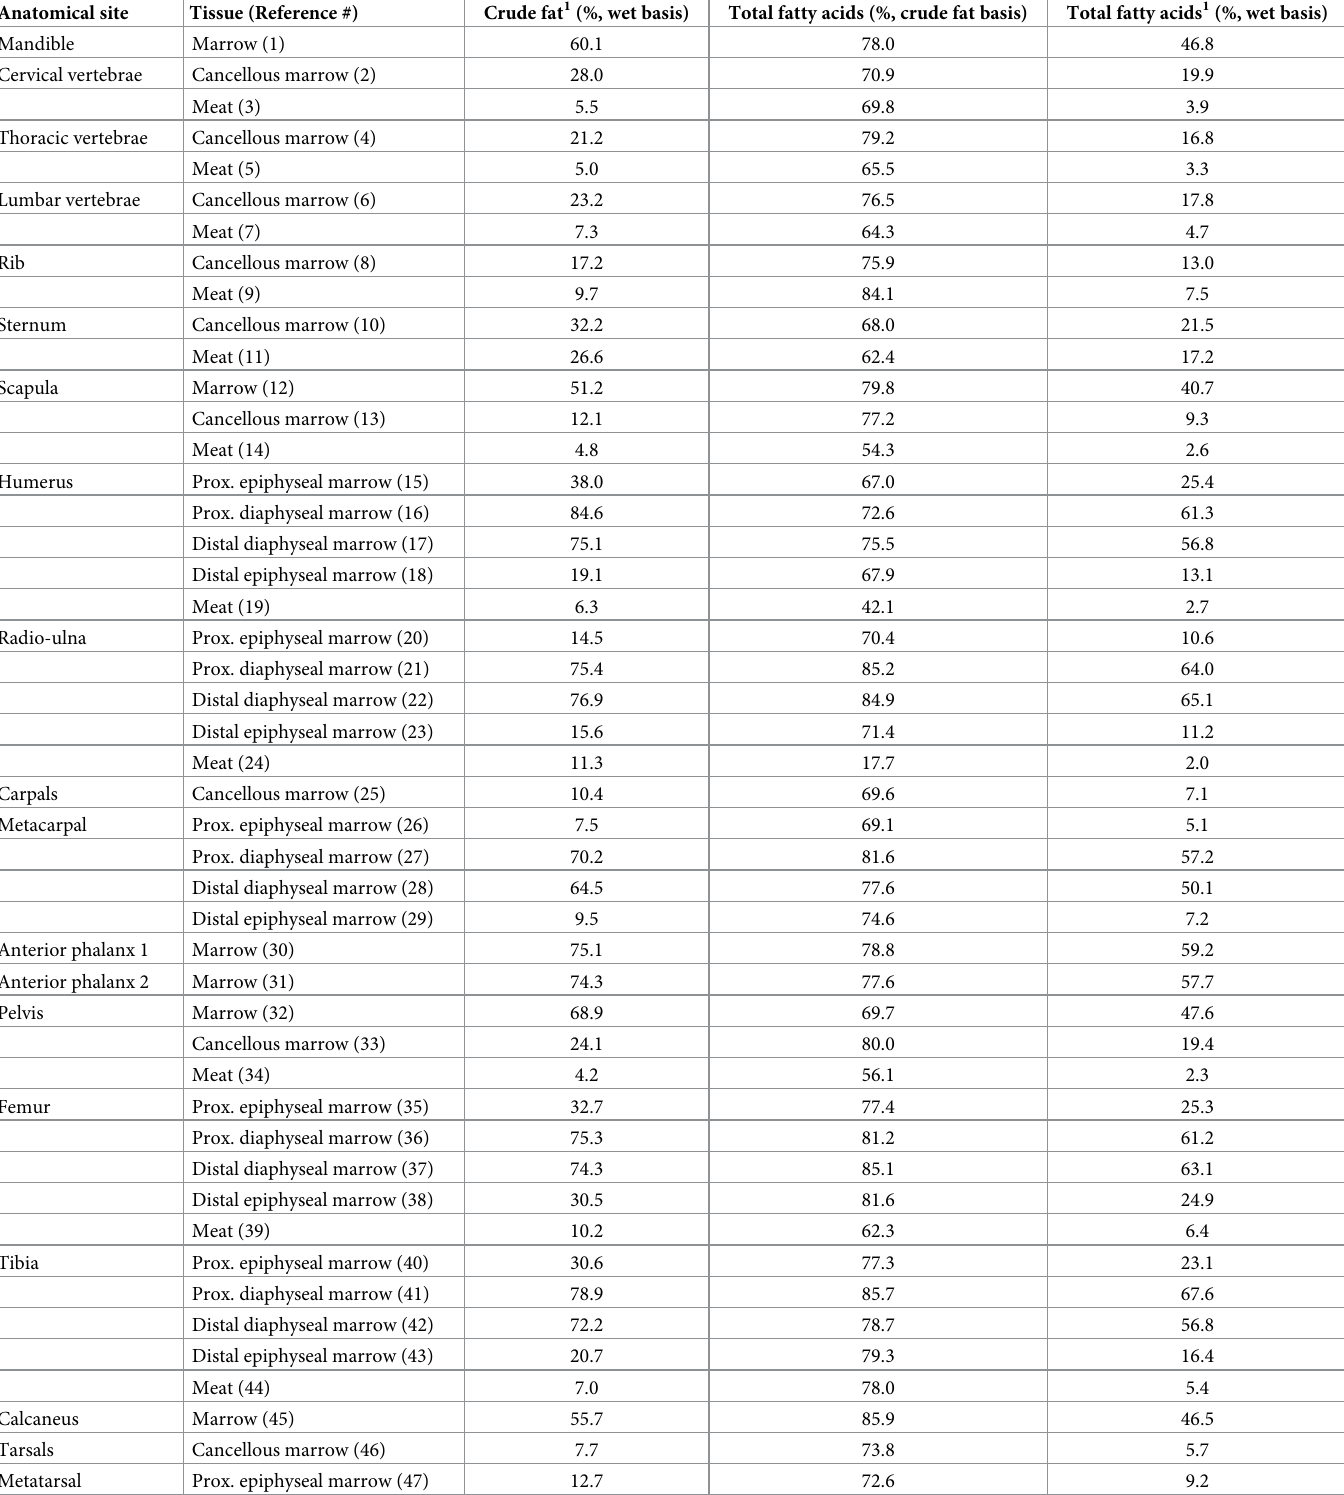
Table 1. Crude fat and fatty acid content of various body tissues in caribou. The values are averages for the two animals. Anatomical site